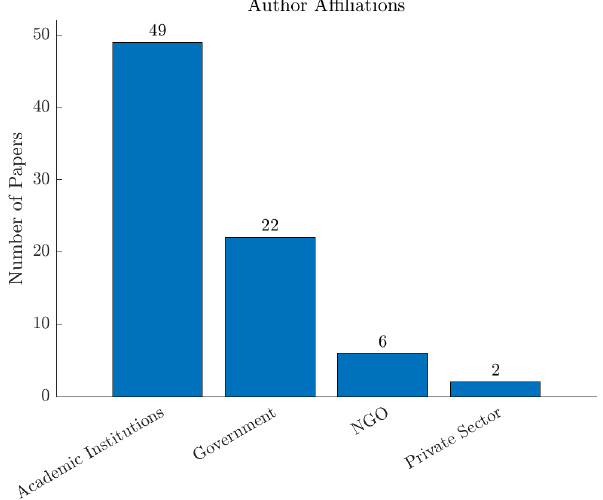
Figure 3. Number of documents with at least one author affiliated with an organization or institution from an academic institution, the government, an NGO (non-governmental organization), or the pri- vate sector. Note that the sum of the documents is greater than 50 because most documents had multiple authors who may be affiliated with different